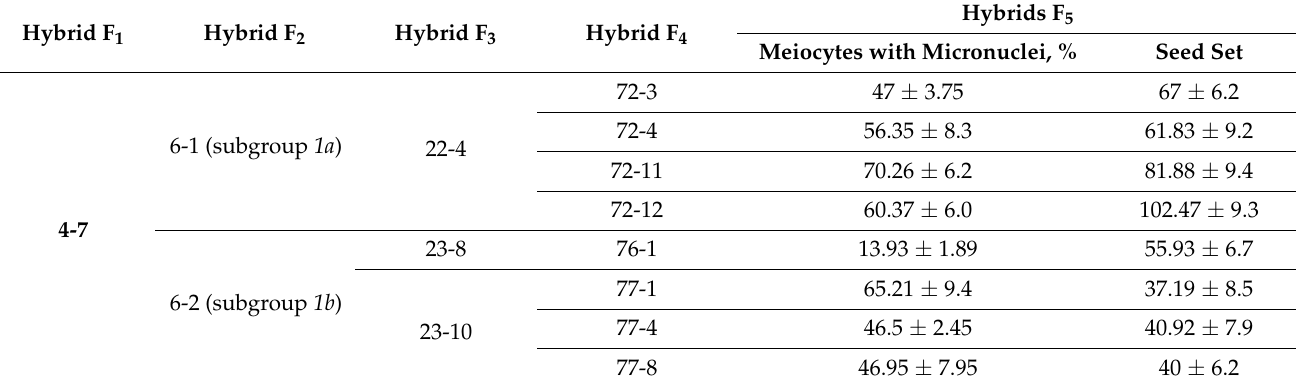
Table 4. Micronucleus formation at telophase II and seed sets in F 5 plants of Group 1.